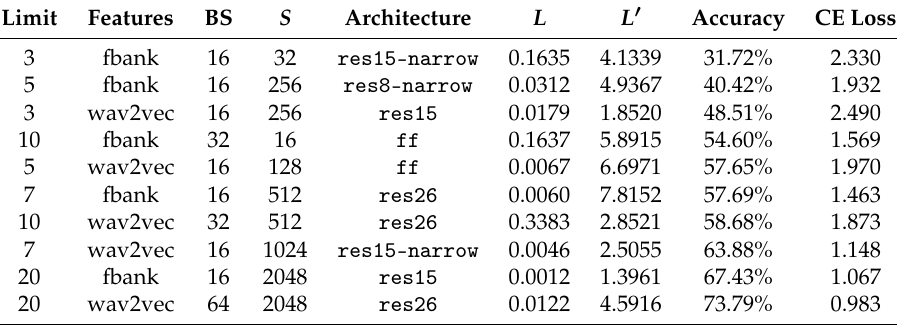
Table A2. Test metrics and hyperparameters on the Russian